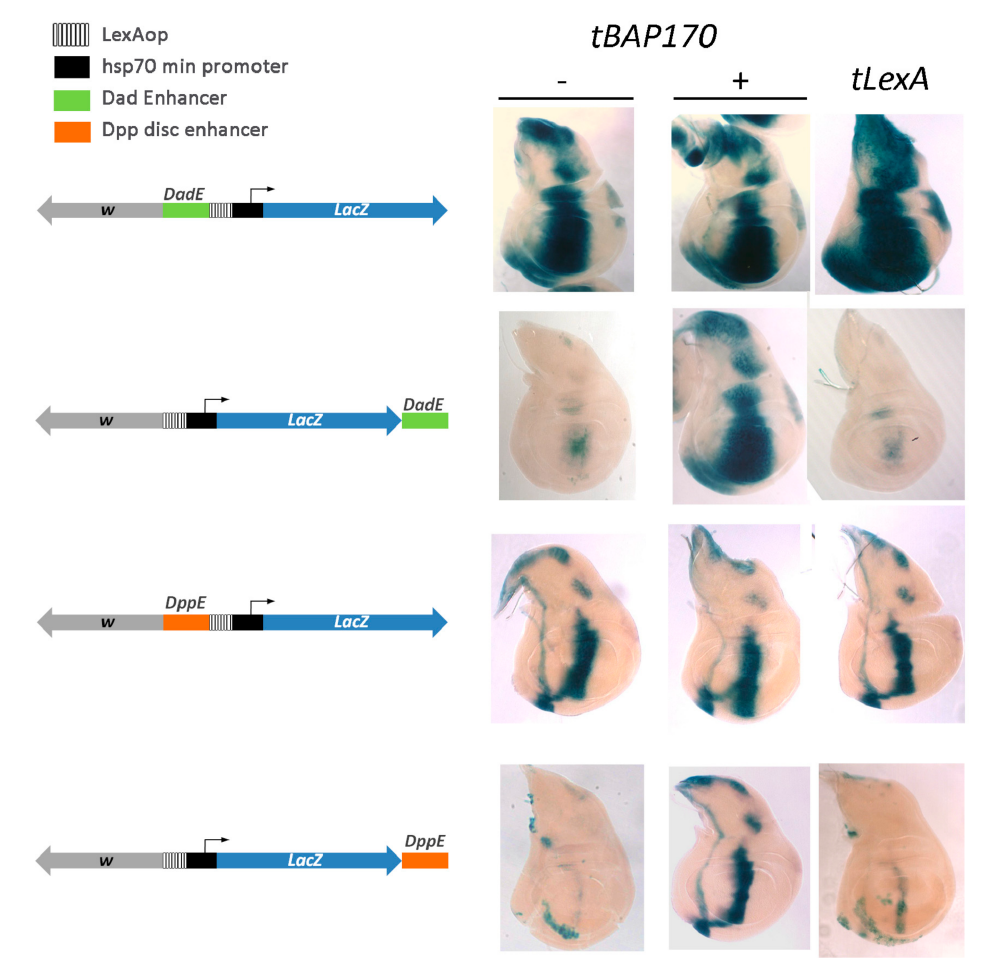
Figure 4. tBAP170 functions as tethering factor between the promoter and distant enhancers. Beta- Gal activity in transgenic lines with the LexAop-hsp70-LacZ constructs carrying the Dad (top) or dpp (bottom) enhancers. The hsp70 core promoter can respond to both enhancers in the absence of tBAP170 when the enhancers are in close 5 (cid:48) proximity (panels 1 and 3, − ), but not when they are at a distance (panels 2 and 4, − ). Conversely, the distant enhancers are capable of activating of the hsp70 core promoter in the presence of tBAP170 (panel 2 and 4, +). From top to bottom, the genotypes are: JFL-attB [DadEnh-lexAop-hsp70-LacZ]/+, JFL-attB [lexAop-hsp70-LacZ-DadEnh]/+, JFL-attB dppEnh-lexAop-hsp70-LacZ]/+, and JFL-attB [lexAop-hsp70-LacZ-dppEnh]/+. The absence ( − ) or presence (+) of the P tub - LexA:BAP170 driver is indicated. Reporter expression in the presence of tLexA is given as a